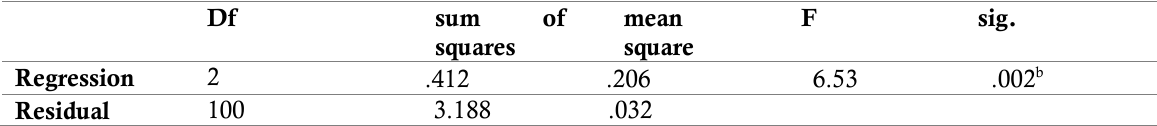
Table 7 . Results of regression of medium TV viewers’ achievement motivation sum of